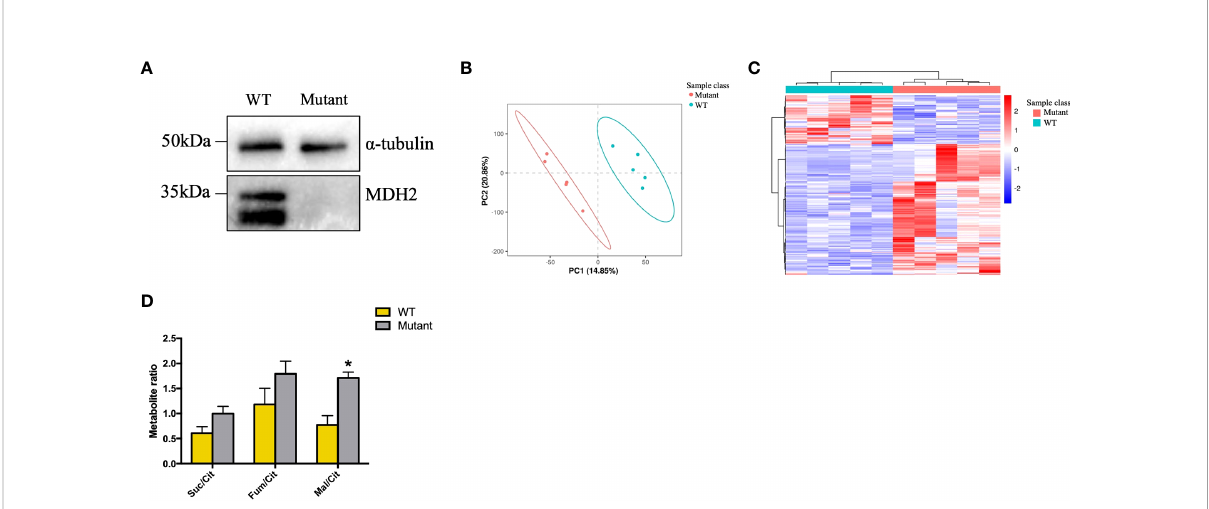
FIGURE 5 rs6720 leads to loss of MDH2 expression in HMy2.CIR cells and disturbed crebs cycle. (A) Western blot analysis with anti-MDH2 antibodies in rs6720 mutant and WT HMy2.CIR cells. a-tubulin was used as loading controls. (B) The scores plot of PLS-DA model of the LS-MS (positive model) spectral data between the selected PCs. Each point in the graph represents a sample. Different colors represent different groups, and different color circles represent different PCA groups. (C) Results of clustering patterns of metabolites differential expression. Red represents upregulation, blue represents downregulation. Different color bars represent different groups. (D) Metabolite ratios assessed by liquid chromatographic tandem-mass spectrometry in mutant and WT HM у 2.CIR cells. Suc, succinate; Cit, citrate; Mal, malate; *p<0.05.